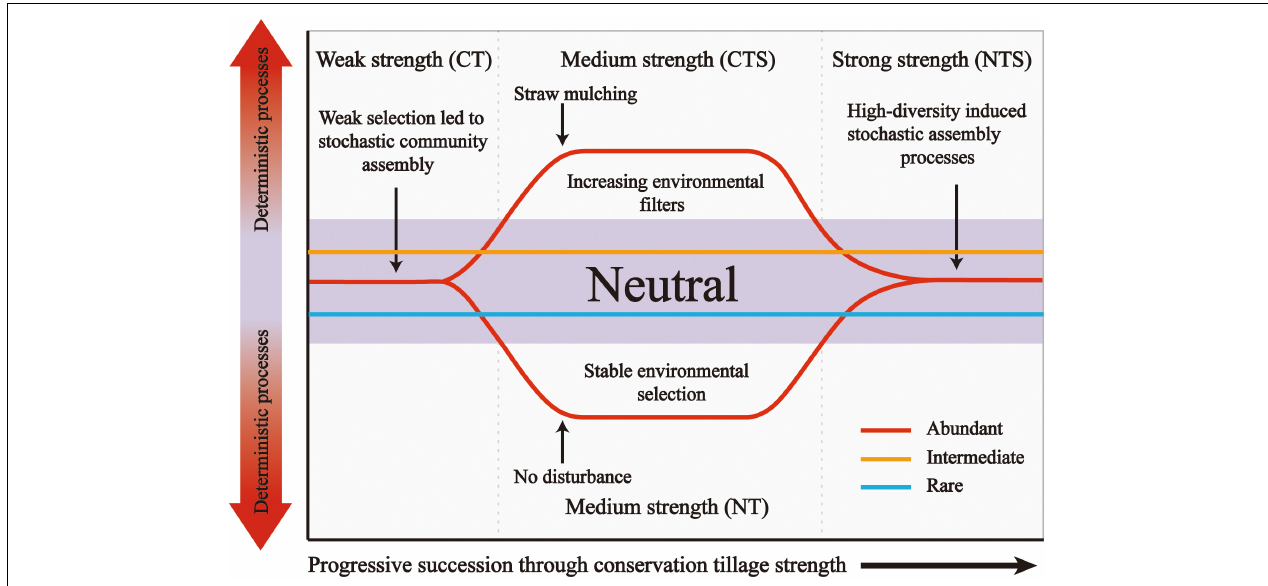
FIGURE 7 | Conceptual model showing how ecological selection dominates the structure of fungal sub-communities through conservation tillage strength. Weak conservation tillage strength, CT; Medium conservation tillage strength, CTS and NT; Strong conservation tillage strength, NTS.